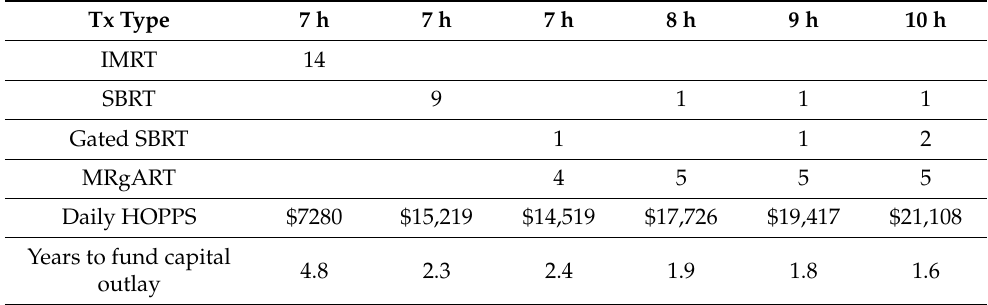
Table 2. Number of daily patients and daily HOPPS reimbursement according to treatment